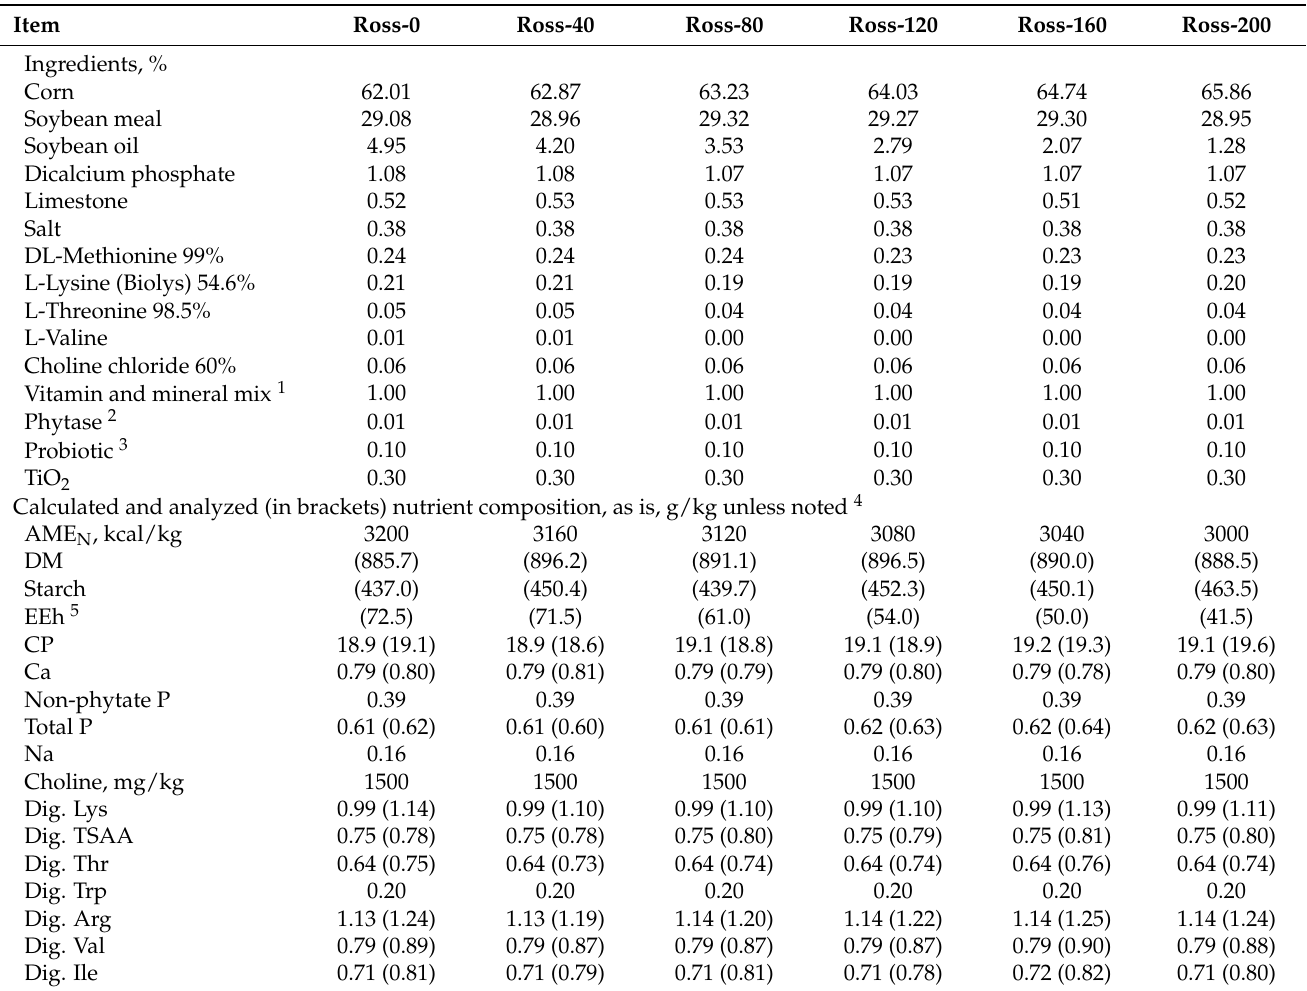
Table 3. Ingredient and nutrient composition of the experimental diets used as finisher, as